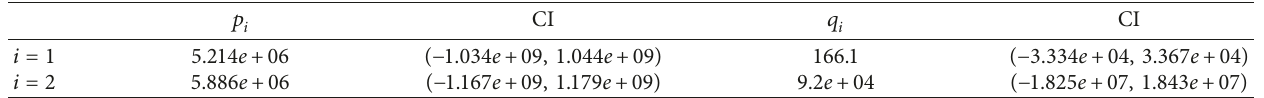
Table 30: AZI vs. Entropy.